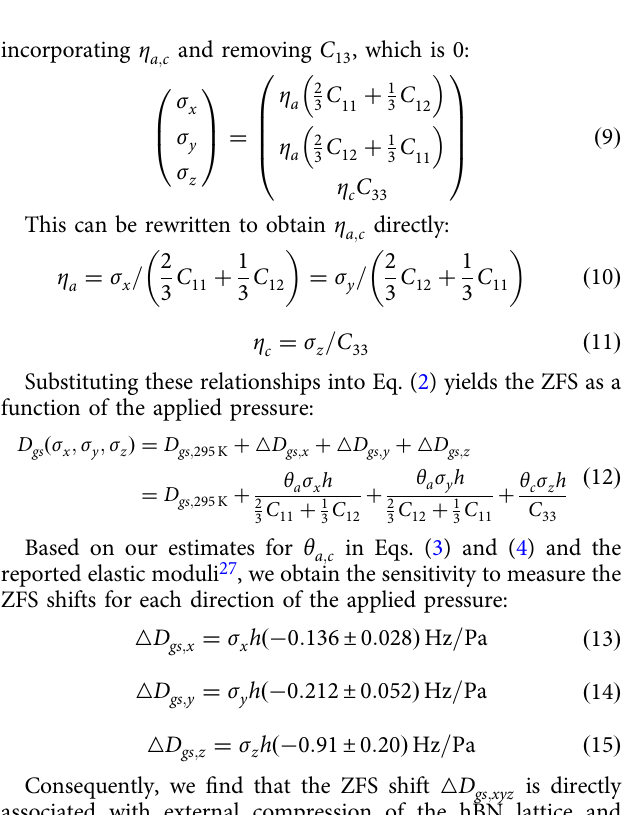
Fig. 3 Zero- fi eld splitting dependence on the lattice parameters a and c . a Combined three-dimensional representation of plots ( b − d ) with the slopes θ θ fi tted (solid lines) to the experimental data displayed as diamonds. The ZFS reference temperature T = 295 K a and c (shown also ( c , d )). Equation (2) is is marked by the red dot. The assignment of colors of fi tting lines (blue for 8.5 mT and cyan for 0 mT) is the same as in Fig. 2. b Comparison of lattice parameters in the temperature range 5 − 350 K. c Change of ZFS 4 D gs ; a caused by the temperature-dependent lattice parameter a . d Change of ZFS 4 D gs ; c caused by temperature-dependent lattice parameter c .